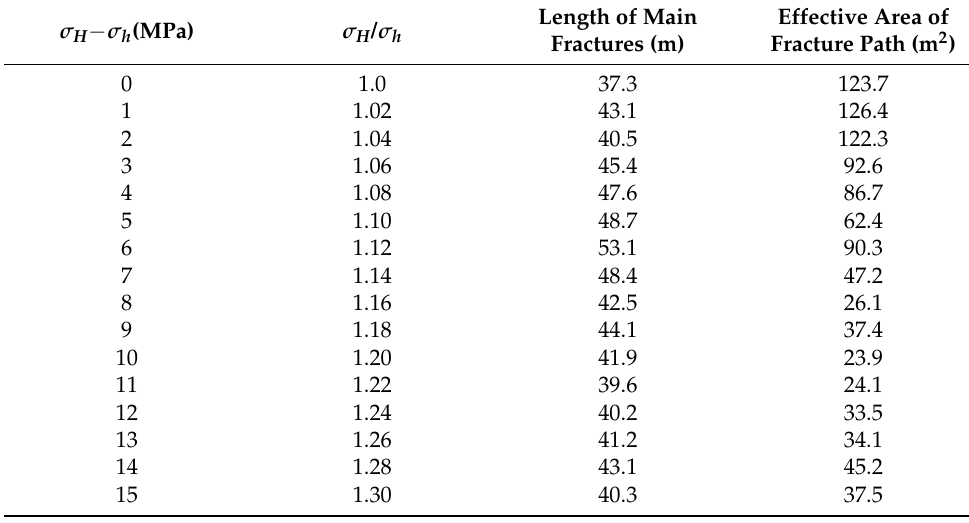
Table 3. Fracture parameters under different horizontal